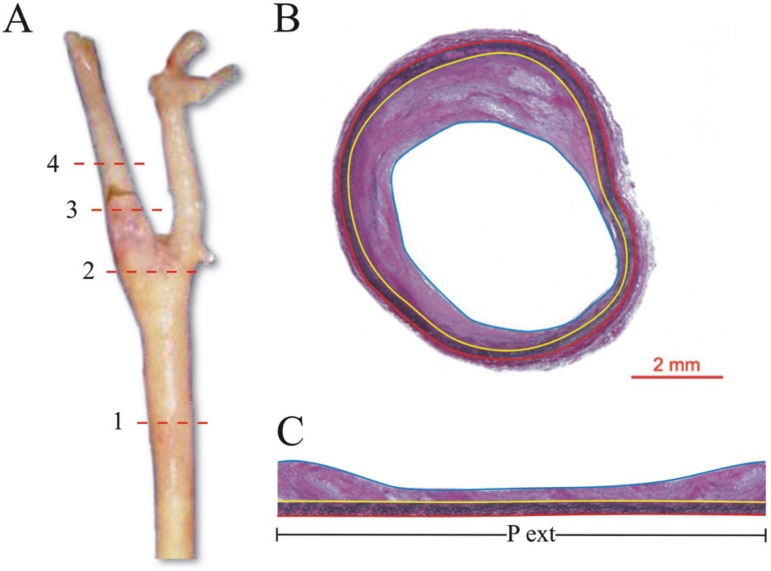
(A) Right carotid artery and the site of 4
cross-sections: (1) the greatest common carotid artery
stenosis; (2) 1 cm below carotid artery bifurcation; (3)
1cm above carotid artery bifurcation; (4) the greatest
internal carotid artery stenosis; (B) Histological
representation of common carotid artery using Verhoeff’s
stain. Red tracer: external elastic lamina; yellow
tracer: internal elastic lamina; blue tracer: lumen. (C)
Flat section of common carotid artery (Figure 2B). For
the calculation of intima media thickness, the
intima-media area was divided by the external perimeter
(area between red and blue tracer), delimited by
external elastic lamina (red). Pext=perimeter of
external elastic lamina. Calibration bar=2 mm.